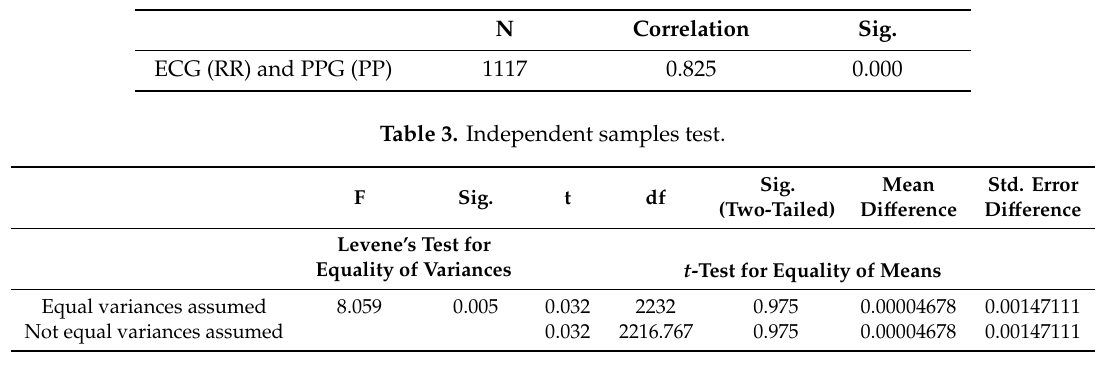
Table 2. Paired samples correlations.